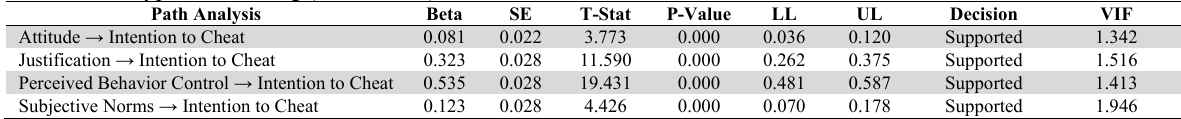
The result of hypothesis testing (direct effect) Path Analysis